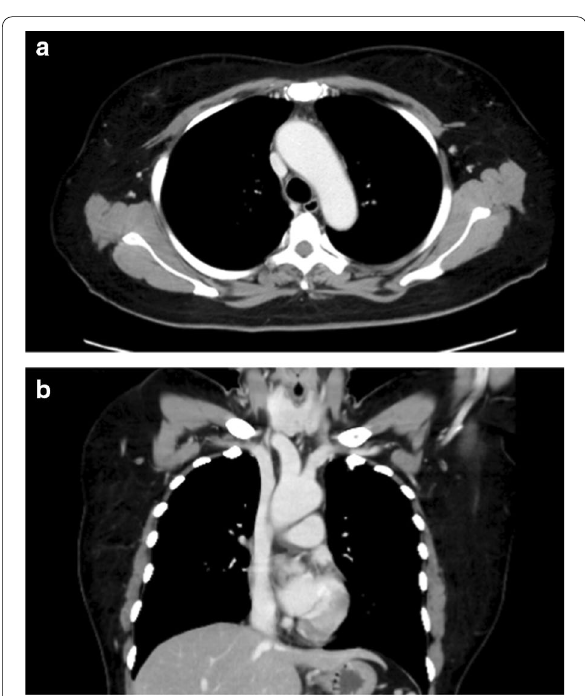
Fig. 3 Computed tomography (CT) scan after steroid treatment. CT scan on day 39 showing decrease in the wall thickening of the aortic arch. a Axial plane; b coronal